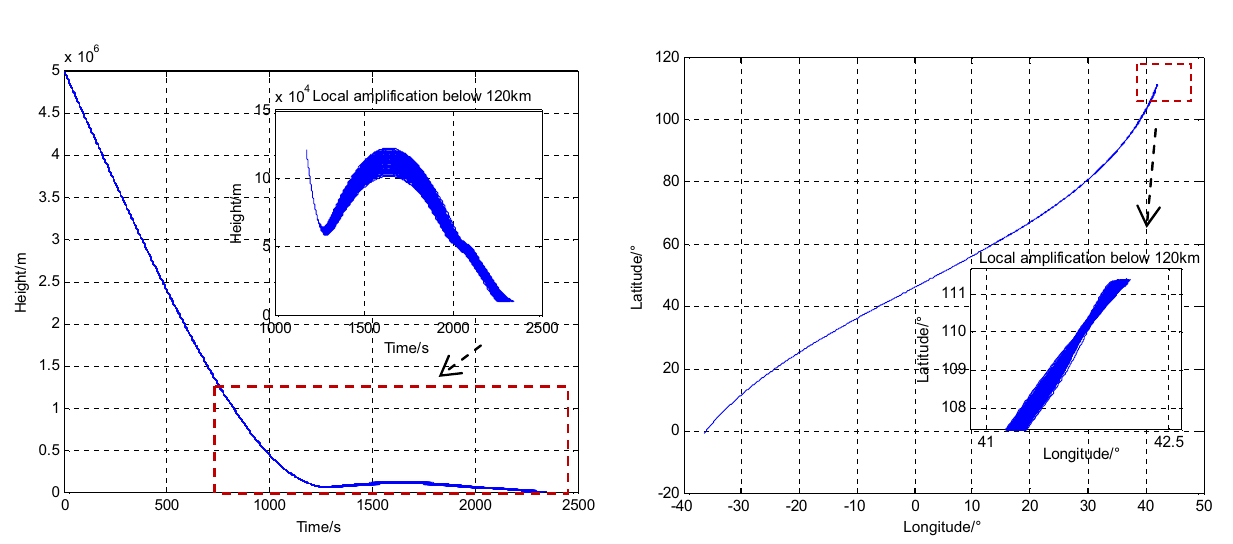
Figure 3: The distribution diagram of sub - satellite points in trajec - tory feature information base.